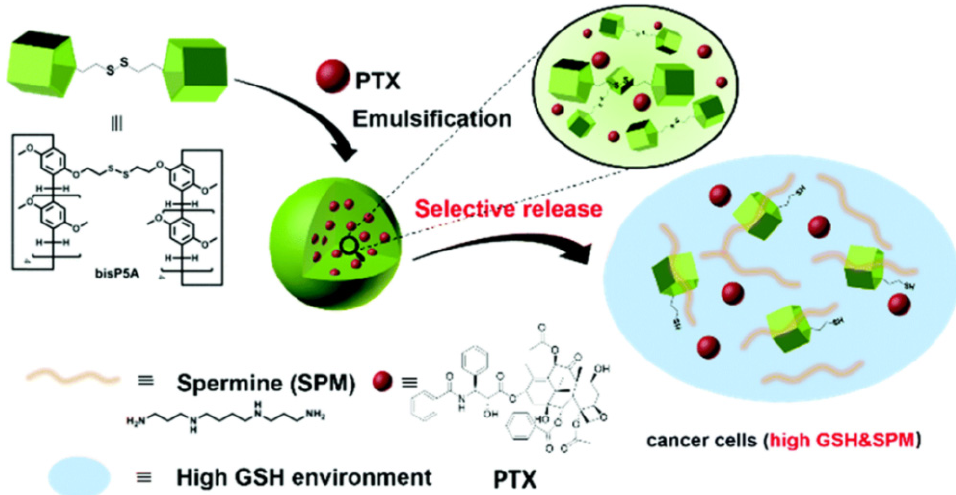
Figure 6. Schematic illustration of the formation of bisP5A NPs and their stimuli-responsive drug release. Reproduced with the permission of reference [84]. Copyright © Royal Society of Chemistry 2019.